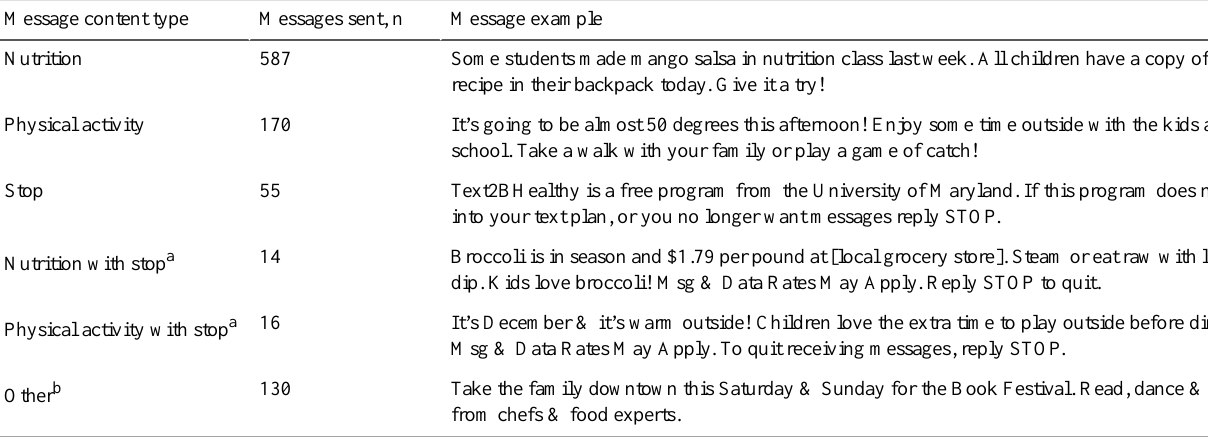
Table 1. Message types, frequency, and examples of the last message